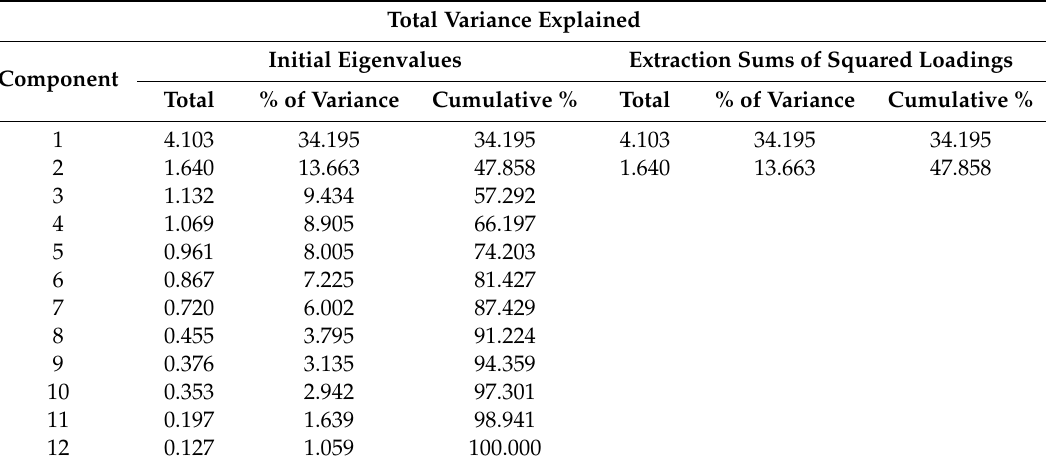
Table 2. Extraction Method, Principal Component Analysis.